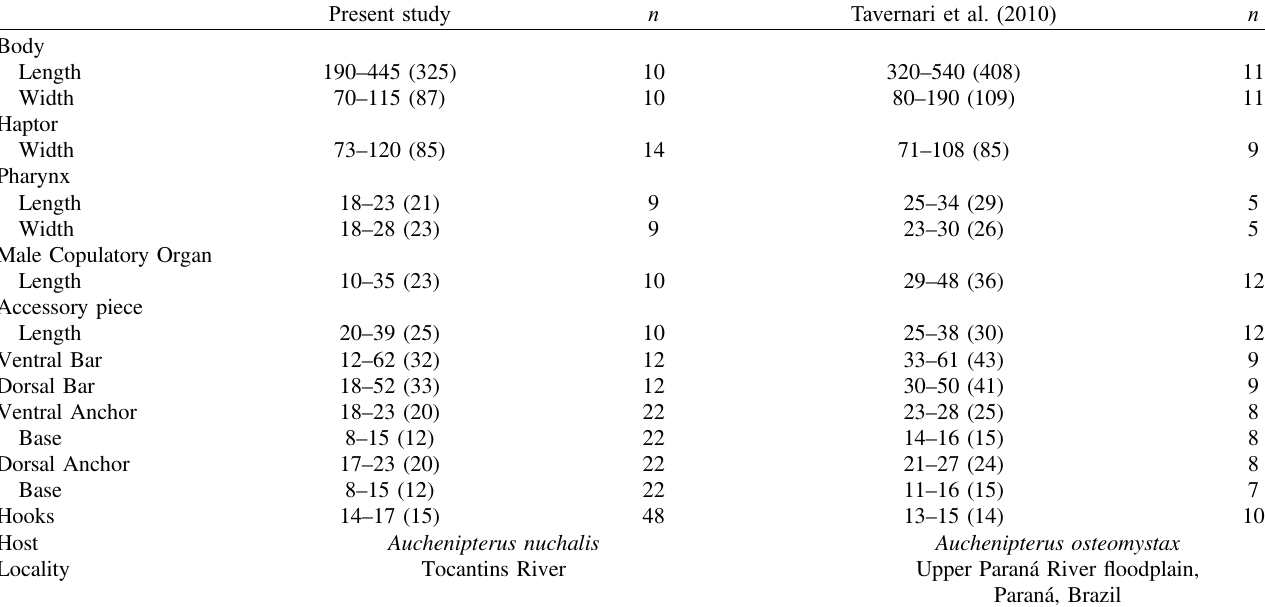
Table 1. Comparative measurements ( l m) of specimens of Demidospermus osteomystax Tavernari, Takemoto, Lacerda & Pavanelli, 2010 from different hosts and localities ( n means number of measurements).